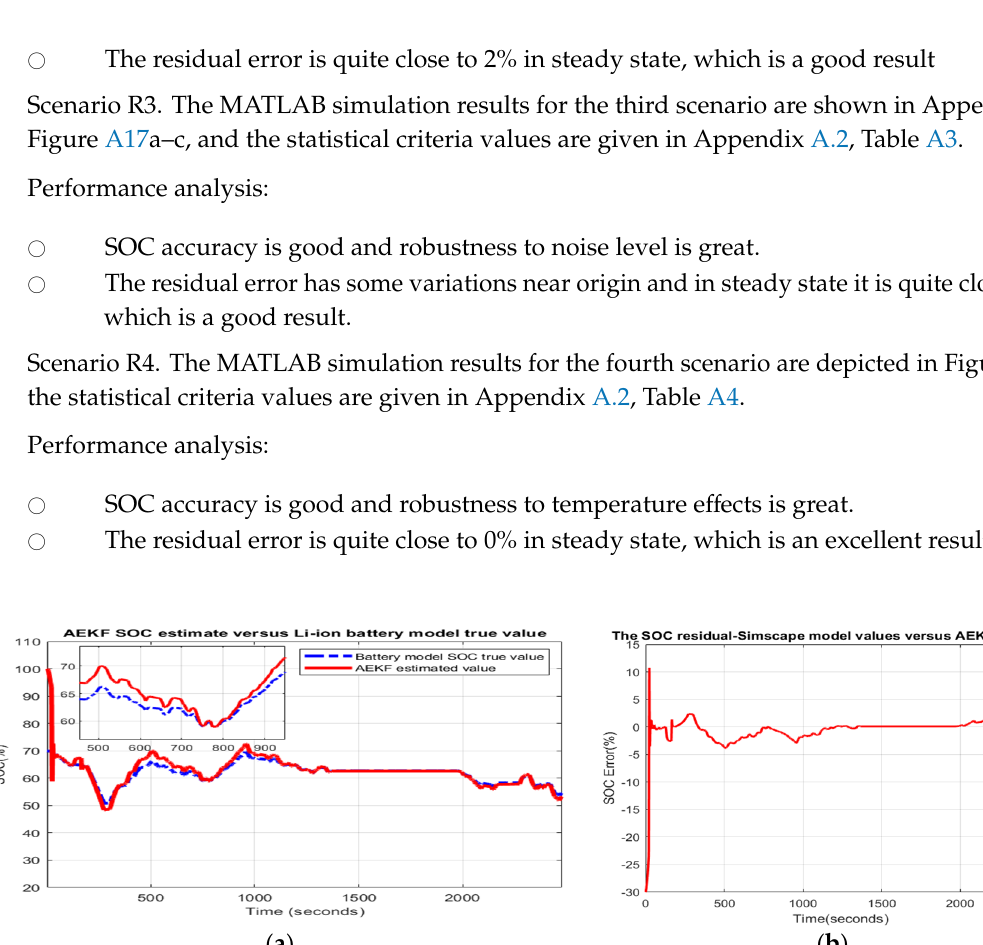
SOC value versus battery model true value; ( b ) SOC residual.